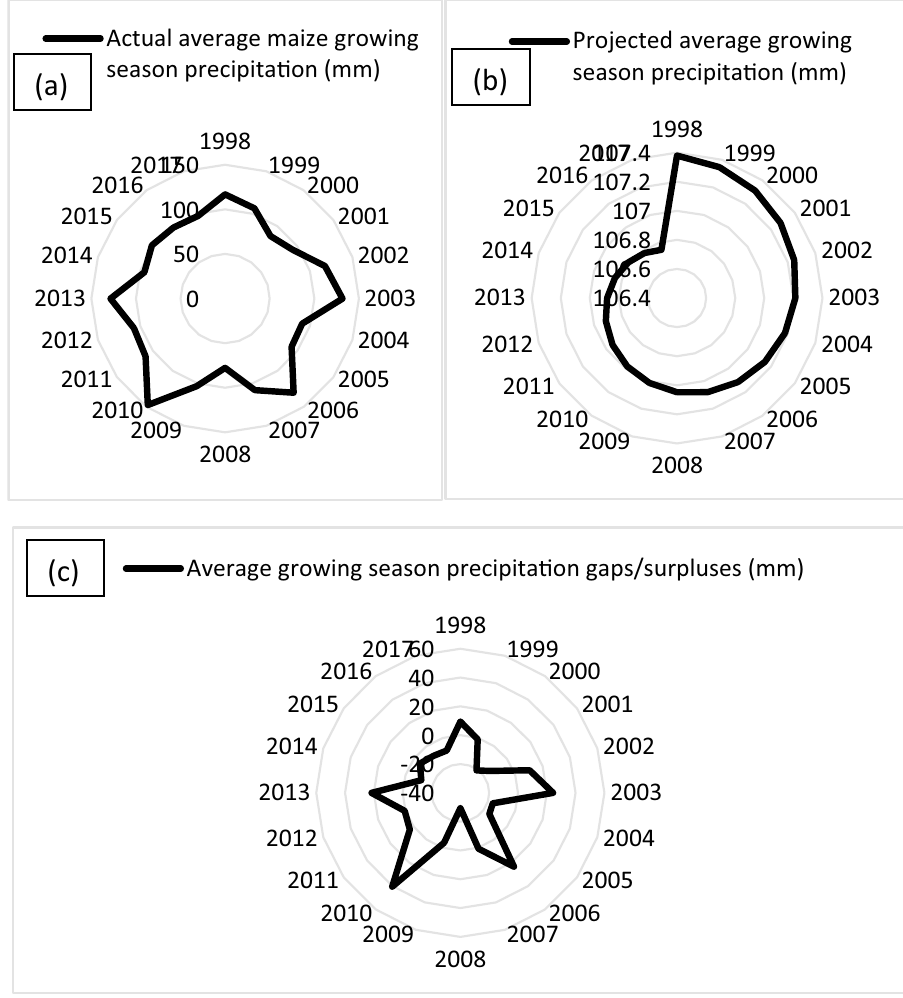
Fig. 2 Actual ( a ), projected ( b ) average maize growing season precipitation (mm) and c aver- age growing season precipita- tion (mm)